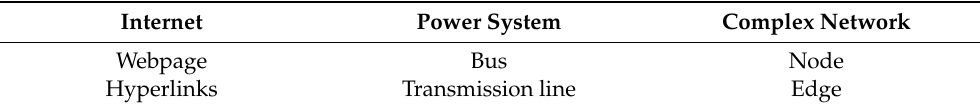
Table 1. Comparison between each part of power system, Internet, complex